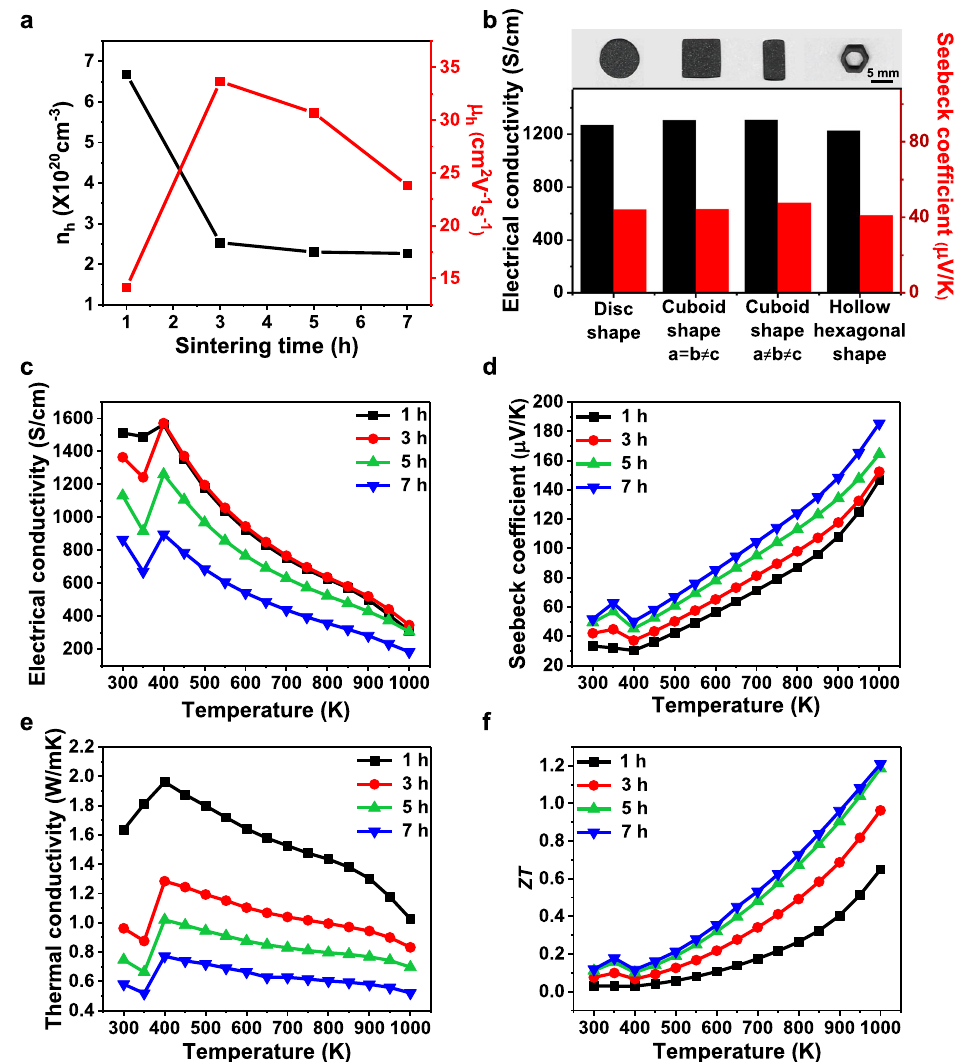
Fig. 4 TE properties of the 3D-printed Cu 2 Se samples. a Room-temperature hole concentrations and mobilities of the Cu 2 Se samples sintered at 1, 3, 5, and 7 h at 873 K. b Room temperature electrical conductivities and Seebeck coef fi cients of various shapes of Cu 2 − x Se samples. c – f Temperature-dependent ( c ) electrical conductivities, d Seebeck coef fi cients, e thermal conductivities and f ZT values the Cu 2 Se samples sintered at 1, 3, 5, and 7 h at 873